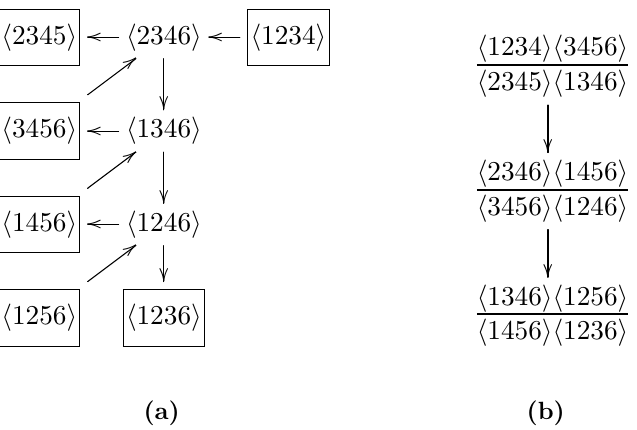
Figure 1. (a) One of the 14 quivers for the Gr(4 ; 6) cluster algebra, with each vertex labeled by its associated A -coordinate and the frozen coordinates in boxes. (b) The same quiver with frozen vertices omitted and with each mutable vertex labeled by its associated X